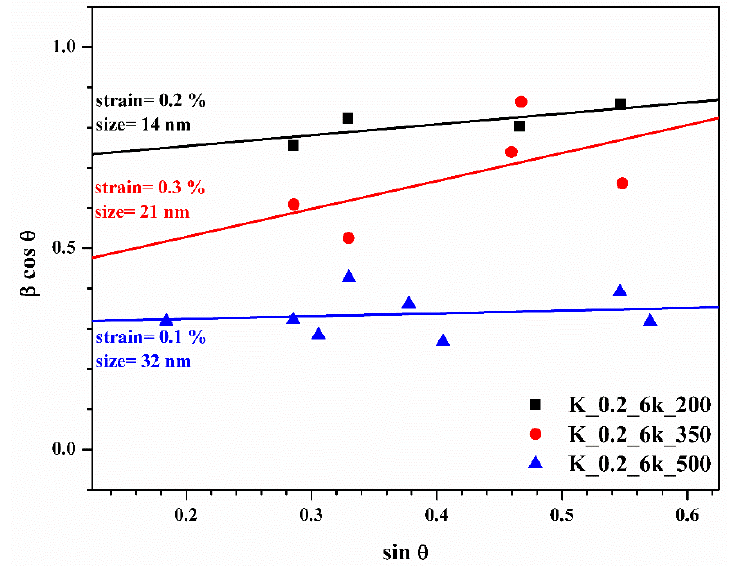
Figure 6. The Williamson–Hall (W-H) analysis (β, integral breadth of diffraction peaks; θ, Bragg diffraction angle) of CZTS thin films treated at 200 °C (black line), 350 °C (red line), and 500 °C (blue line).